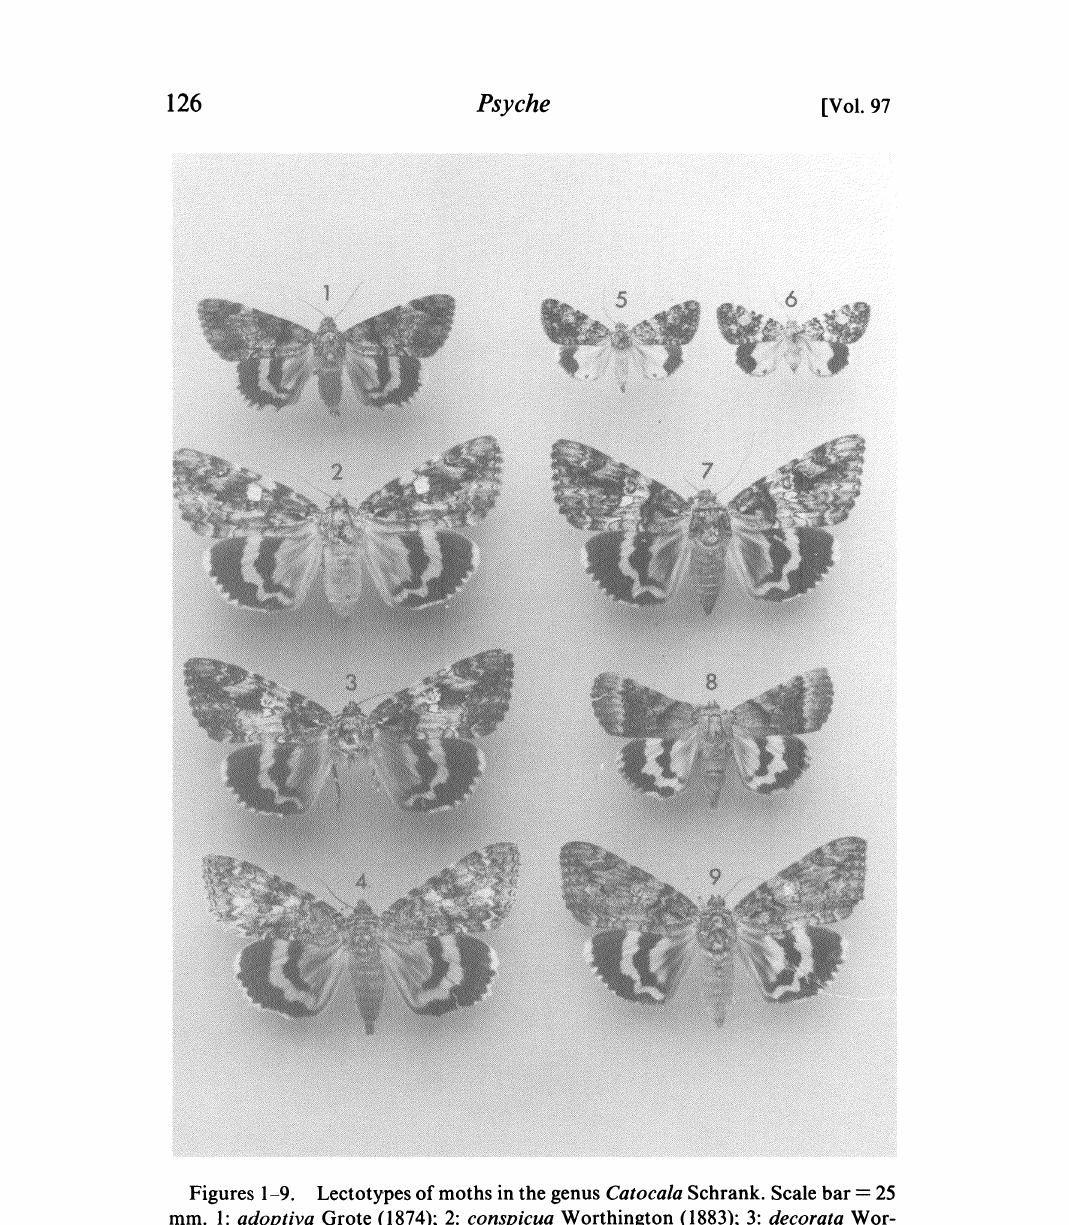
Figures 1-9. Lectotypes of moths in the genus Catocala Schrank. Scale bar 25 mm. 1: adoptiva Grote (1874); 2: conspicua Worthington (1883); 3: decorata Wor- thington (1883); 4: lucilla Worthington (1883); 5: melanotica Reiff (1916); 6: novan- gliae Reiff (1916); 7: obsoleta Worthington (1883); 8: pensacola Reiff (1919); 9: umbrosa Worthington